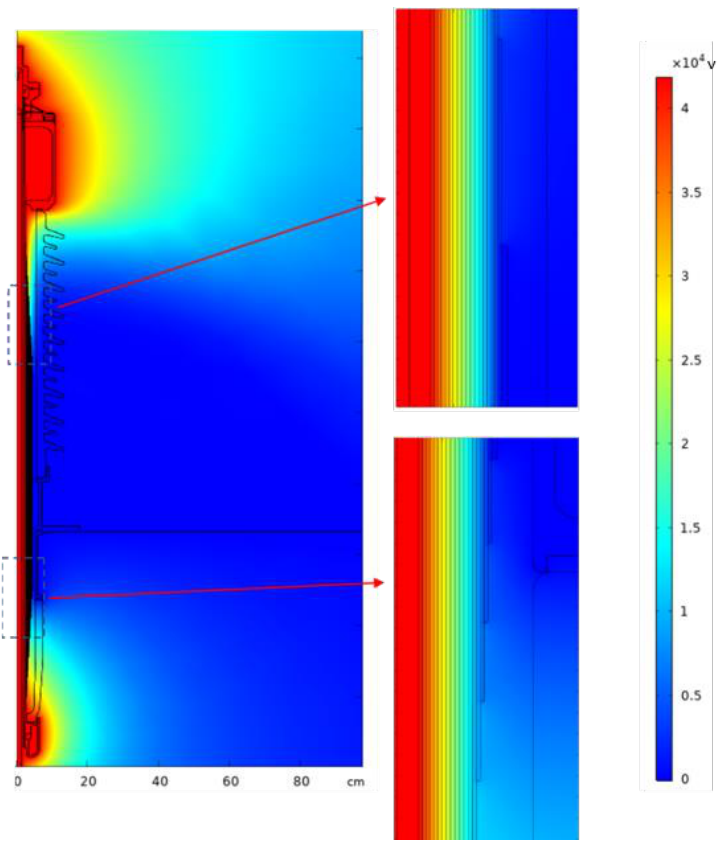
Figure 10. Electric field distribution of the transformer bushing.